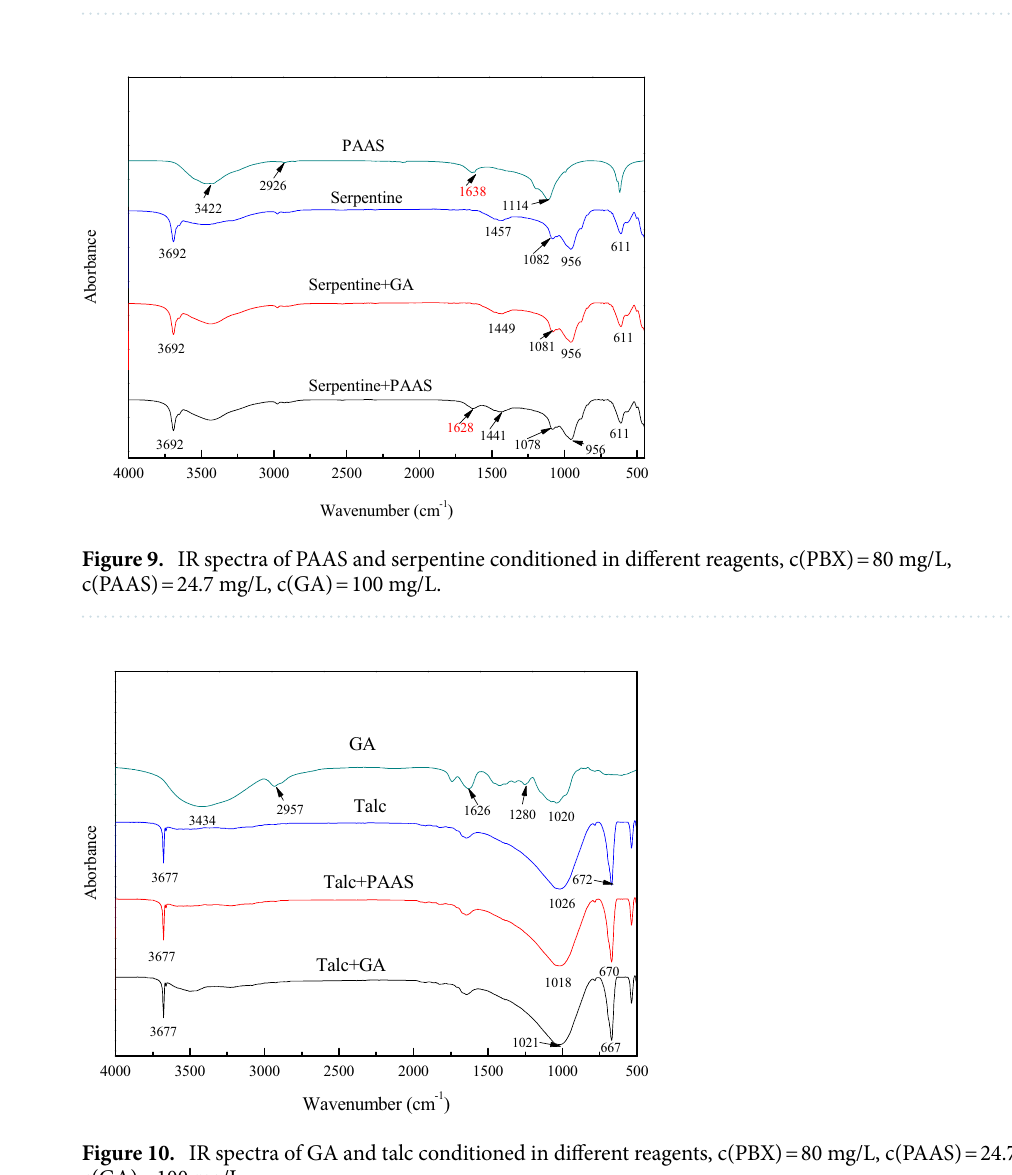
Figure 8. IR spectra of chalcopyrite in the absence and presence of flotation reagents, c(PBX) = 80 mg/L, c(PAAS) = 24.7 mg/L, c(GA) = 100 mg/L.